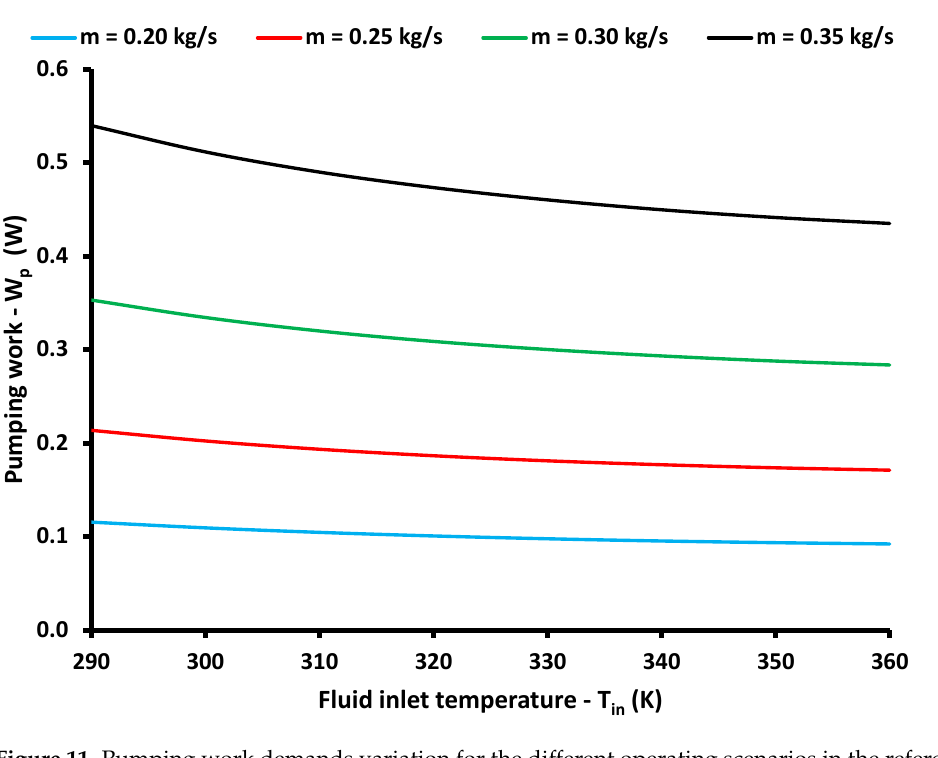
Figure 11. Pumping work demands variation for the different operating scenarios in the reference case of the empty tube.